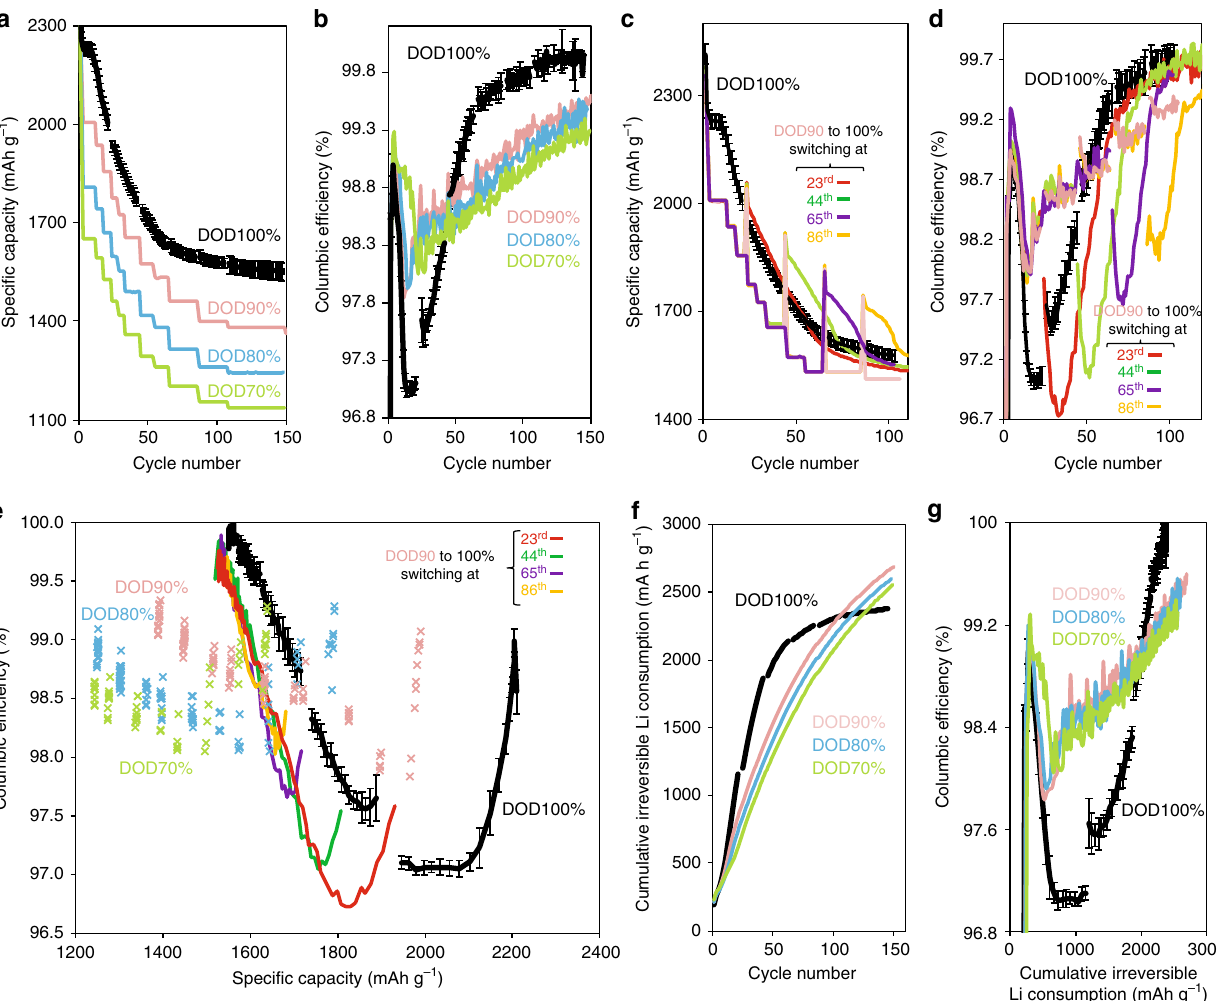
Fig. 4 Baseline electrochemical properties under different lithiation depth controls. Electrochemical properties for type-A electrodes under different depth of discharge (DOD) controls. a Speci fi c capacity and ( b ) Coulombic ef fi ciency (CE) for different DOD controls over 150 cycles. c Speci fi c capacity and ( d ) CE for DOD90% switched to DOD100% at different cycle numbers; the switching points for red, green, purple, and yellow solid lines are the 23 rd , 44 th , 65 th , and 86 th cycles, respectively. e CE as a function of the speci fi c capacity for different DOD controls. Colored solid lines (red, green, purple, and yellow) show the pro fi les switched from DOD90% to DOD100% in ( c , d ). CE is clearly the highest under DOD100% after a certain loss of reversible capacity. f Cycle number plotted over accumulated irreversible Li consumption. The cumulative consumption is the lowest among the given DODs after certain cycles. g CE plotted over accumulated irreversible Li consumption. CE under DOD100% protocol is the highest among the given DOD controls after a certain amount of sacri fi cial Li consumption. Note that the CE error bars for DOD70 – 90% are all below ± 0.1% and therefore omitted in ( b , d , e , g ). The corresponding results for type-B electrode are shown in Supplementary Fig.